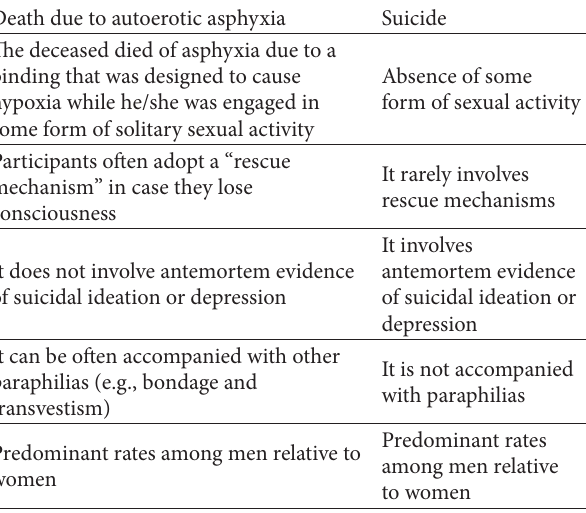
Table1:Comparisonofthecharacteristicsofdeathduetoautoerotic asphyxia and